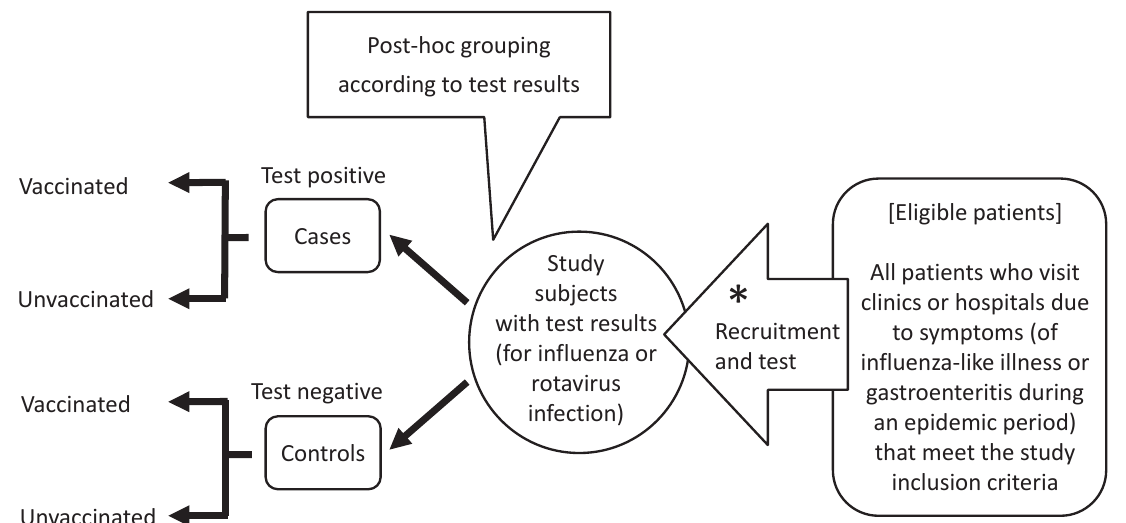
Figure 2. Outline of test-negative design to evaluate in fl uenza or rotavirus vaccine e ff ectiveness. Selection bias may occur at the procedure “ recruitment and test ” ( * ). So, all eligible patients (or a subset of eligible patients who are selected in a random or systematic manner) have to be recruited in the study and all study subjects (or a subset who are selected in a random or systematic manner) have to be tested. If the study subjects are limited to those who received the clinician- ordered test in a routine clinical setting, the application of the test would be related to the likelihood of having the disease under investigation (outcome) or vaccination status (exposure), resulting in biased sampling (non- representativeness) of the study subjects even if the study subjects meet the inclusion criteria. [Modi fi ed from the following source: Fukushima W, Hirota Y. Basic principles of test-negative design in evaluating in fl uenza